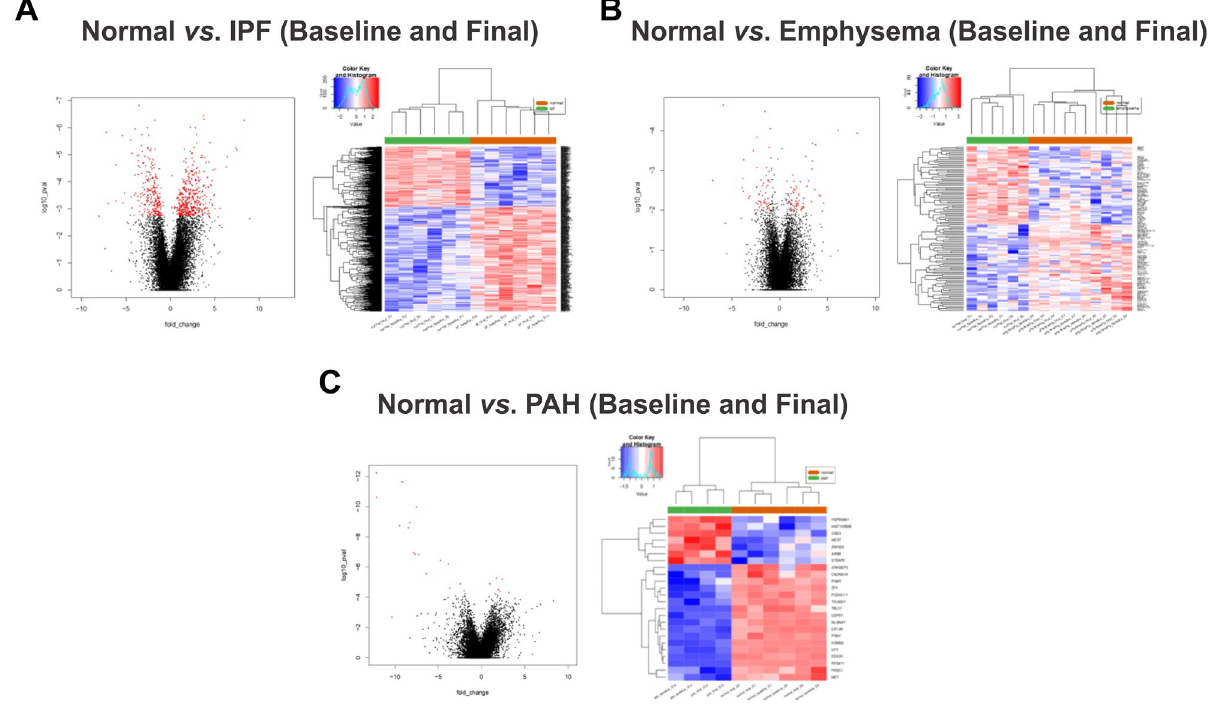
Figure 7. Heatmap and volcano plots of Differentially Expressed Genes before and after EVLP in IPF ( A ), Emphysema ( B ), and PAH ( C ) (green) compared to Normal (orange). Raw p value < 0.01 and |logFC|> 1.